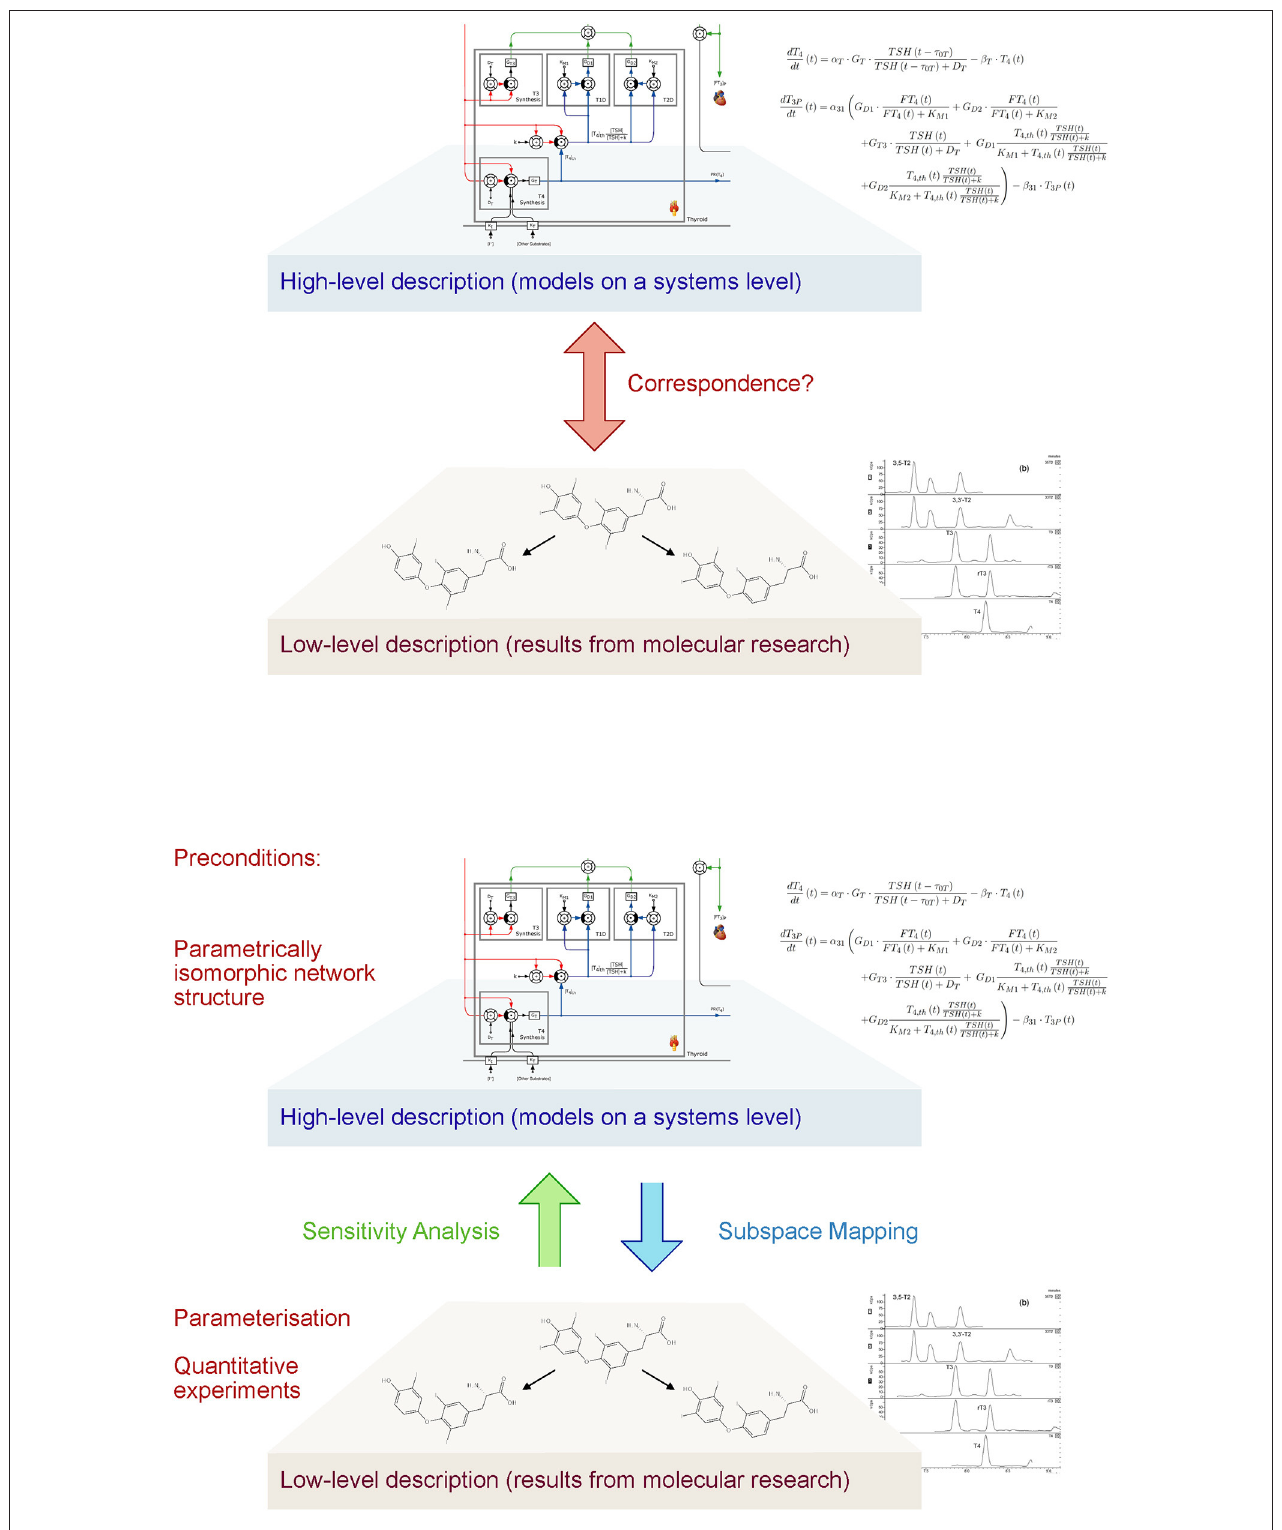
FIGURE 3 | Today’s biomedical research is faced by the challenge that descriptions of the systems of interest are restricted to different sublevels. A high-level theory covers a systems view, addressing large subsystems, e.g., multi-organ feedback control systems or even the whole organism including psychosocial relations. This is complemented by a low-level description of molecular structure and reactions. Unfortunately, the vertical translation, e.g., how molecular data are integrated into the high-level system description, is difficult. Methods of vertical integration include affine subspace mapping (top-down inference), sensitivity analysis (bottom-up reasoning) and graphical tools. They require, however, certain preparative steps on both tiers of research to be feasible (74).